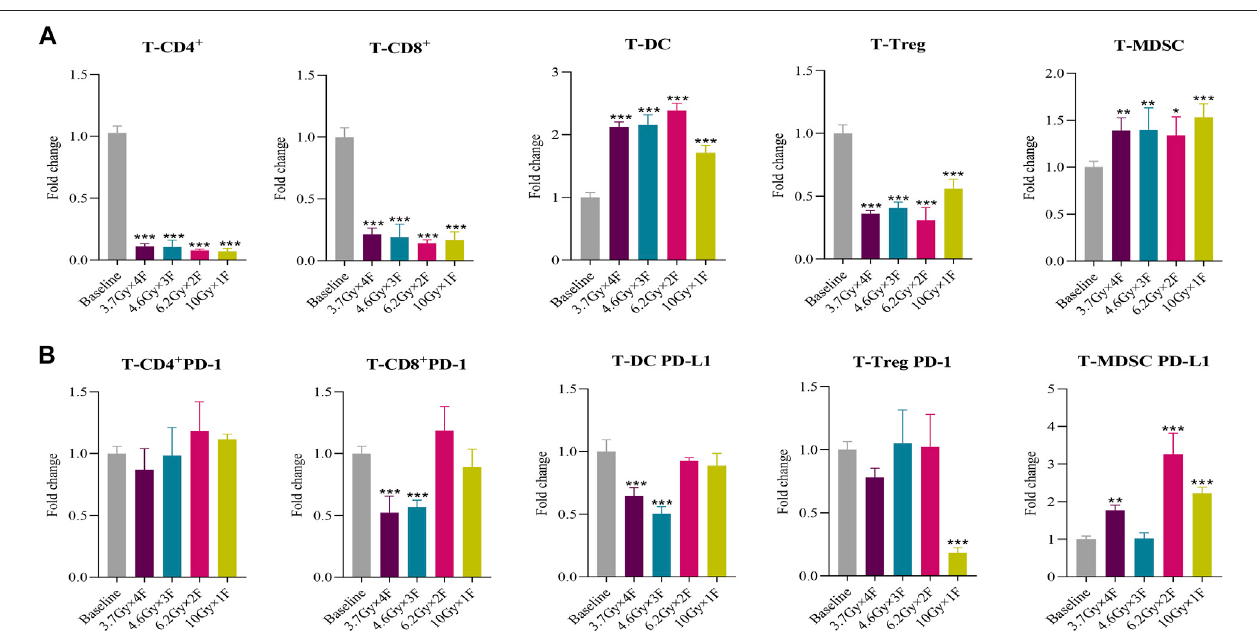
FIGURE4| ImmunecellsandPD-1/PD-L1changesoftumortissuesinmouseat48 hafter4differentfractionationradiotherapies. (A) Changesofdifferentimmune cells at 48 h after radiotherapy in mouse tumor tissues. (B) Changes of PD-1 and PD-L1 expression at 48 h after radiotherapy in mouse tumor tissues. * p ＜ 0.05,** p ＜ 0.01, *** p ＜ 0.001, compared with